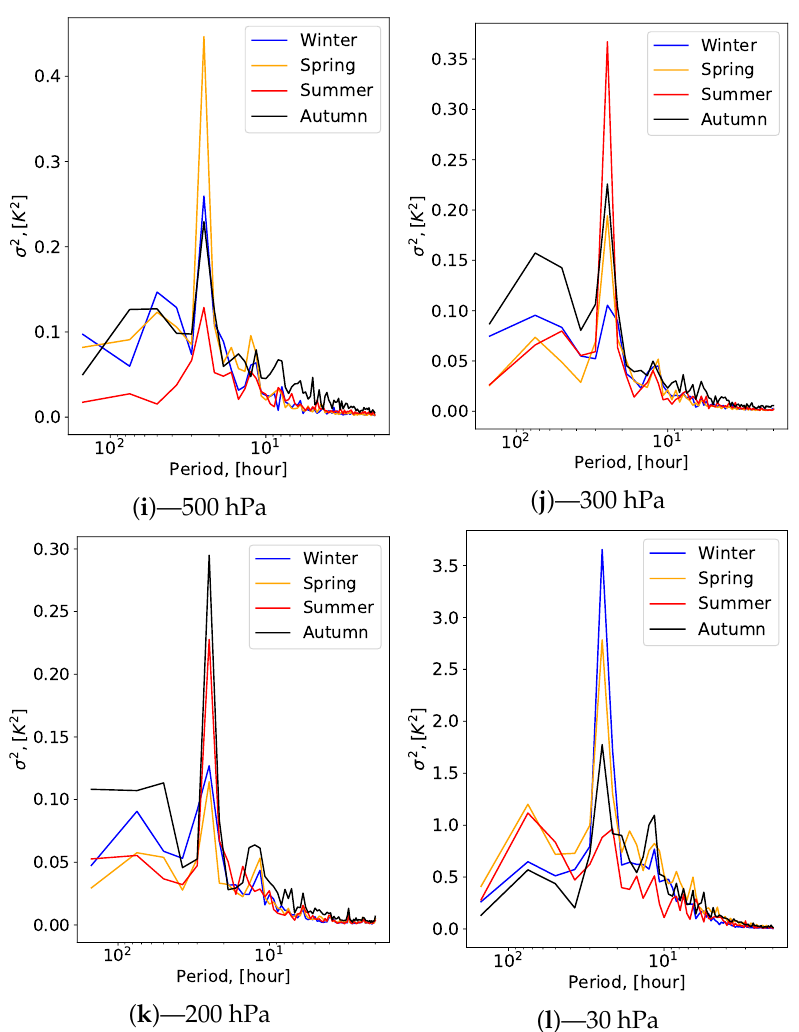
Figure 8. Energy spectra of air temperature fluctuations at the Nha Trang